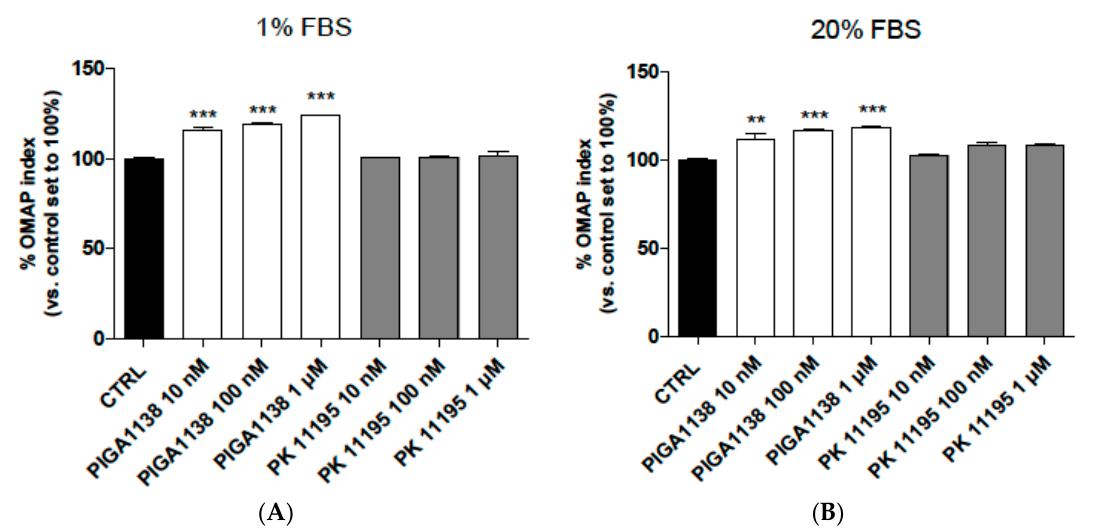
Figure 5. In vitro response of the human astrocytes to the PIGA1138 and PK11195 treatments. ( A ) Human astrocytes were treated with different concentrations of PIGA1138 and PK11195 (10 nM–1 µM) in serum-reduced media (1% FBS), and the MTS assay was performed after 48 h of treatment; ( B ) Human astrocytes were treated with different concentrations of PIGA1138 and PK11195 (10 nM–1·µM) in complete medium and the MTS assay was performed after 48 h of treatment. The data are expressed as percentages of metabolic activity compared to the control, which was set to 100%, and represent the means ± SEM of three different experiments performed in duplicate. ** p < 0.01, *** p < 0.001 vs. the control.